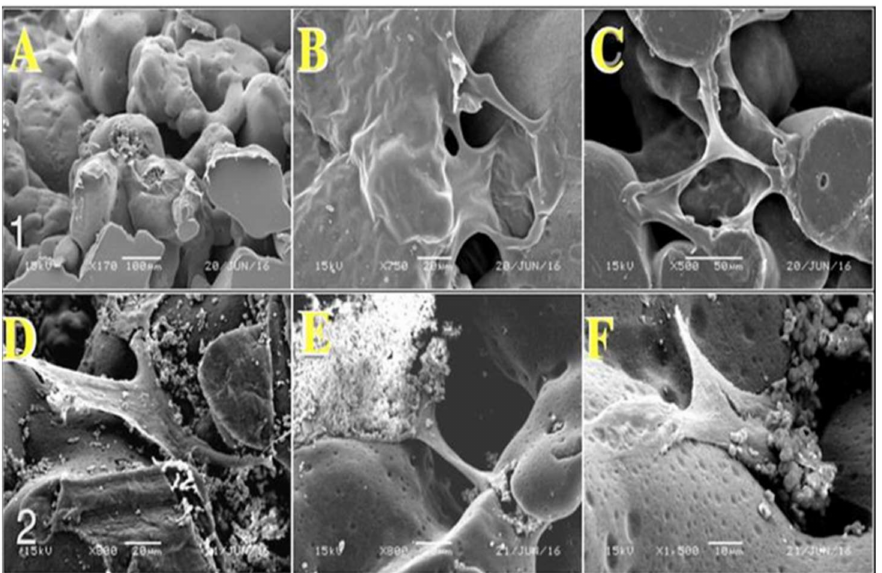
Figure 9. Micrograph of porous polyethylene three days after cell seeding. The first row represents the cell culture on uncoated porous polyethylene discs; cells are mainly found toward the edge of the discs ( A ). Cells are also found crossing the scaffold’s pores ( A – C ). Scale bars = 100, 20, and 50 µ m. ( D – F ) show cells with the typical morphology of stromal cells (polygonal or fusiform). The cells are intermingled with coating material’s crystals, and crystalline apatite on the surface of material can be seen. Cells migrated inside the pores of porous polyethylene. Scale bars = 20, 20, and 10 µ